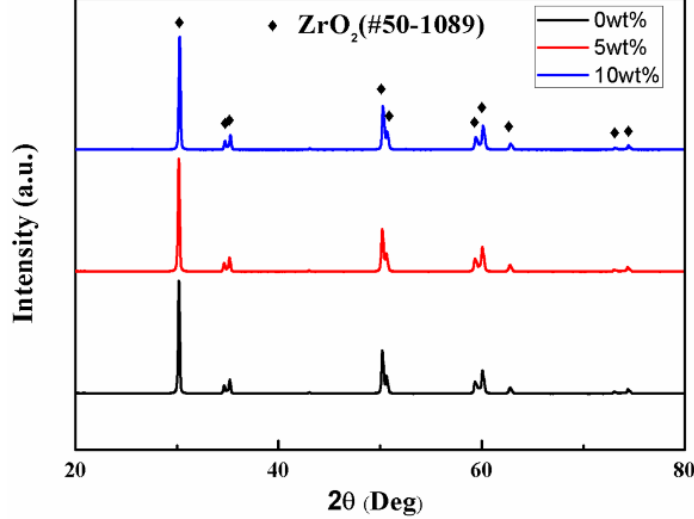
Figure 1. XRD patterns of zirconia ceramics with different stearic acid contents.